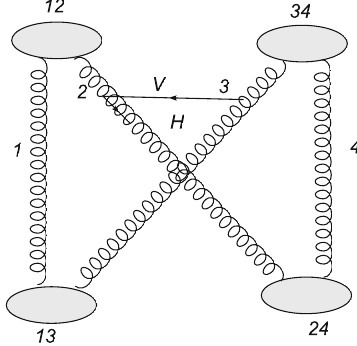
Fig. 4 Contribution from the interaction of reggeons 2 and 3. The sec- ond diagram should be added with the interaction of reggeons 1